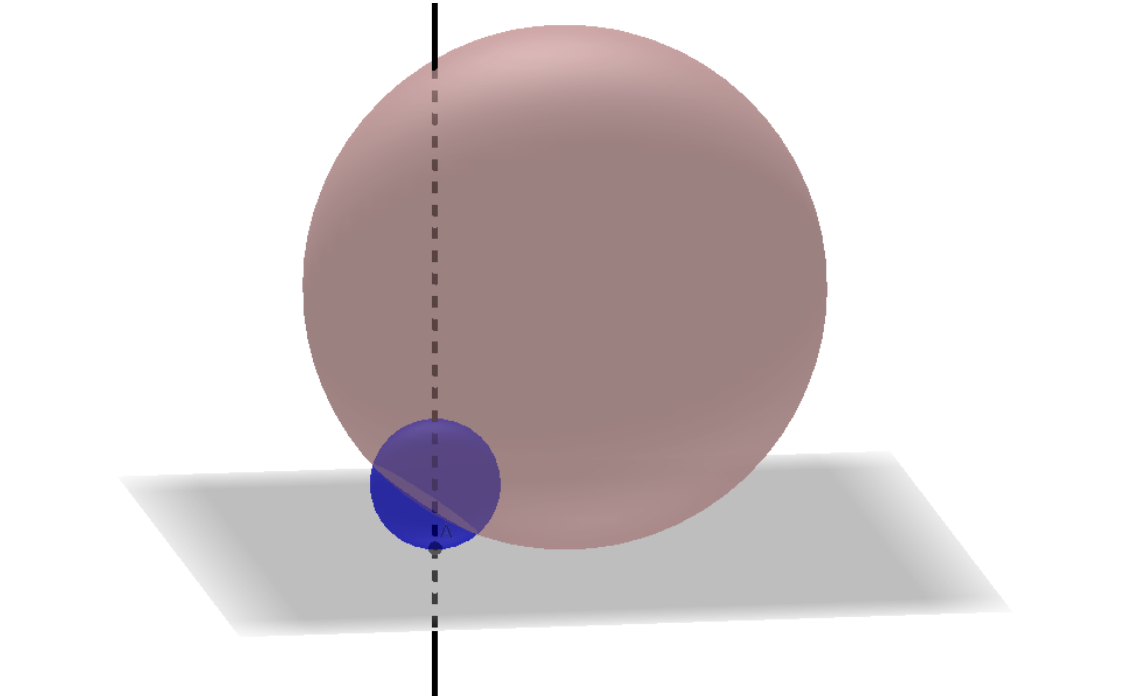
Figure 3. Both the micro-space of a quark (blue) and that of the hadron to which it belongs (beige) are tangent to the flat Minkowski space. The tangency point of the quark micro-space is confined within the vertical projection of the hadronic micro-space (de Sitter horizon). In five-dimensional space this point is a straight line that intersects the hadronic micro-space in two points. The strong charge of the quark is positioned at one of these two points, while its electric and weak charges are positioned at the point of tangency. The same reasoning applies to gluons. Hence, the strong charges of a hadron are located in a closed space, which is the de Sitter hadronic micro-space. From Gauss theorem it follows that the hadron as a whole is